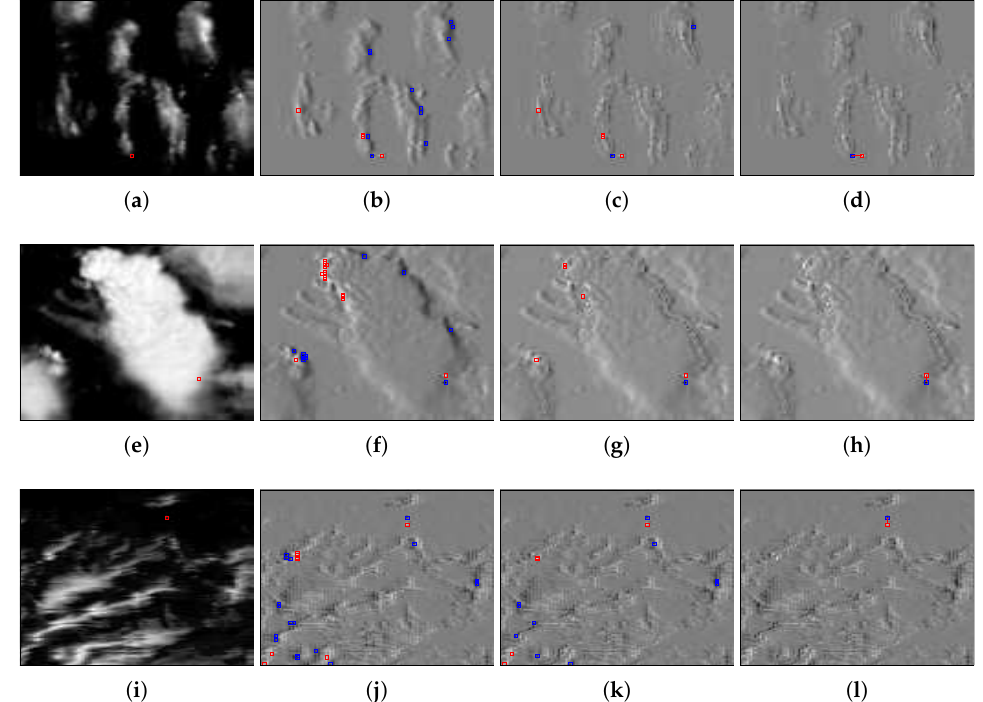
Figure 8. An example of results achieved by the proposed small target detection methods on three images. The red and blue boxes in each image represent the candidate points passing the positive and negative thresholds (as mentioned in Section 3), respectively. ( a – d ) Ragged clouds; ( e – h ) strong clouds; ( i – l ) fluffy clouds.